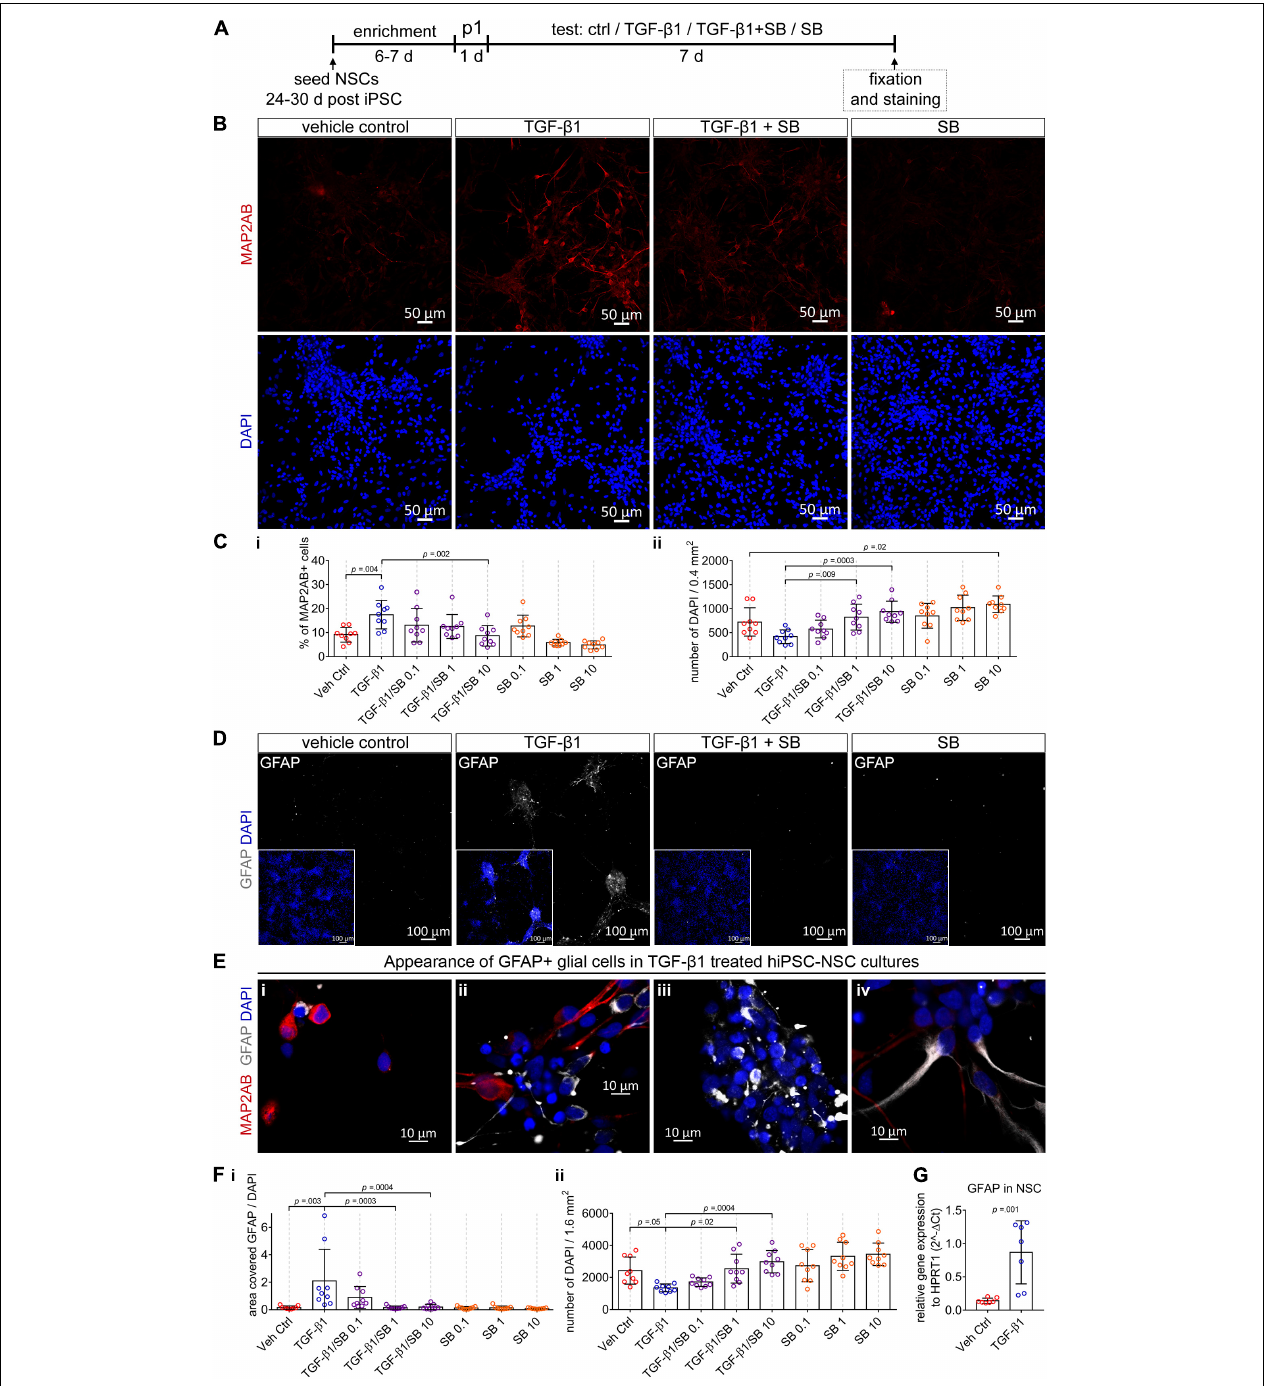
FIGURE 3 | The impact of TGF- β 1 in human iPSC-derived neural stem cell cultures. (A) Schematic representation of the experimental design. (B) Confocal images visualize MAP2AB + neurons in vehicle control, TGF- β 1, TGF- β 1 + SB, and SB treated hiPSC-NSC cultures. (C) Diagrams show the percentage of MAP2AB + neurons (i) and the number of DAPI cells (ii) quantified in the cultures in the indicated conditions (hiPSC line C1, N = 3, n = 2–3). (D) Example overview images (10x) visualizing GFAP + glial cells in vehicle control, TGF- β 1, TGF- β 1 + SB, and SB treated hiPSC-NSC cultures. (E) Example confocal images (40x) visualize the appearance of GFAP + glial cells among MAP2AB + neurons, in TGF- β 1 treated hiPSC-NSC cultures. (F) Diagrams show (i) the area covered by GFAP + glial cells and (ii) the number of DAPI cells quantified in the cultures under the indicated conditions (hiPSC line C1, N = 3, n = 3). (G) Gene expression of GFAP in vehicle control and TGF- β 1 treated cultures (hiPSC line C1 and C2, N = 2, n = 1–2). The data is presented as mean ± standard deviation. Either one-way ANOVA with Tukey’s correction (multiple comparisons) or unpaired t -test was used to calculate the indicated p- values.